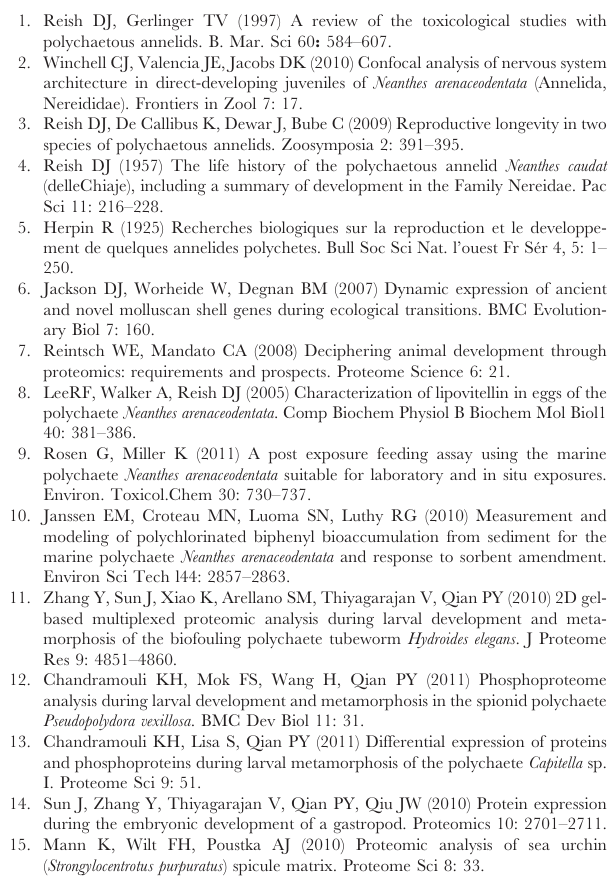
Figure S1 Replicate 2-DE gels of proteome and phos- phoproteome of fertilized ova, and two larval stages of Neanthes arenaceodentata . The gels indicates a technical reproducibility of 2-DE workflow and consistent pattern of protein and phosphoprotein spots between replicate gels.